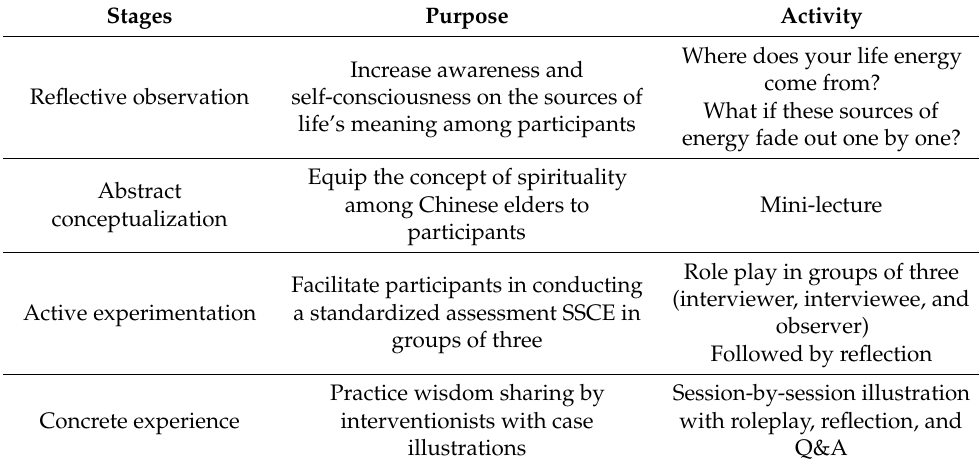
Table 3. Capacity building through experiential